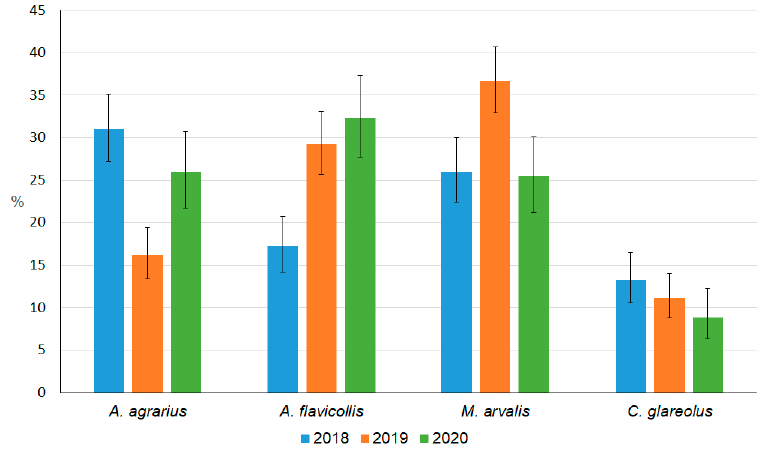
Figure 2. Yearly changes in the proportions (95% CI) of the four most abundant small mammal